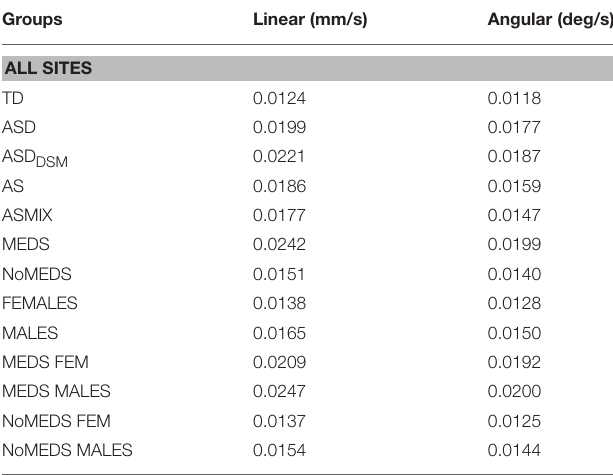
TABLE 1 | Physical values of linear and angular excursions of involuntary head motion detected during the resting state fMRI sessions for each group of all the sites in ABIDE I and II.